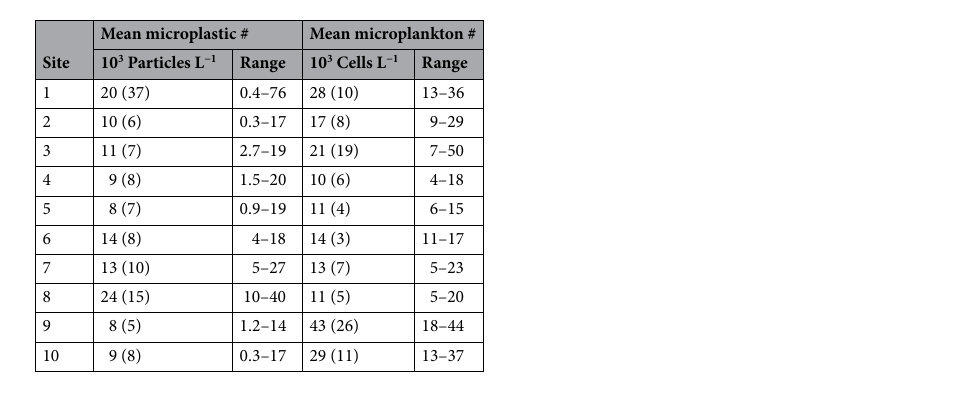
Table 1. Mean values for densities of polystyrene microplastic particles and microplanktonic algae cells over the peak period for microplastic densities, i.e. May–August 2019. Range of values for the period are also shown. Standard deviations are shown in